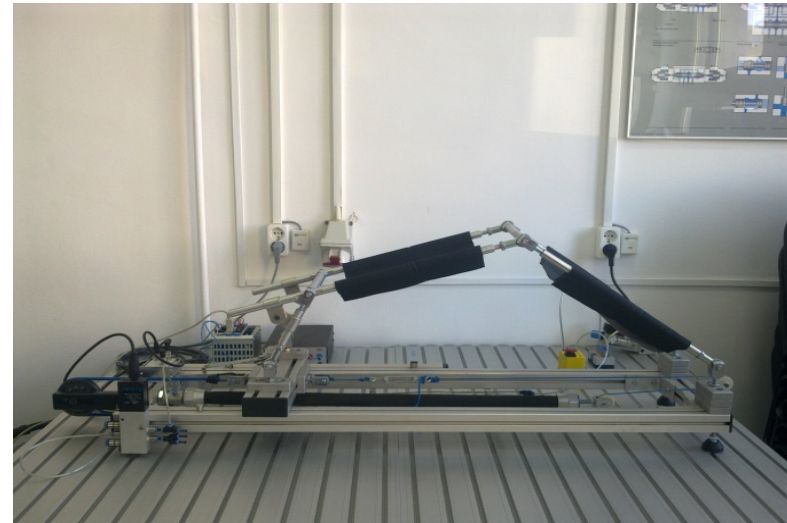
Figure 8. Assistive rehabilitation device for the joints of the lower limb.